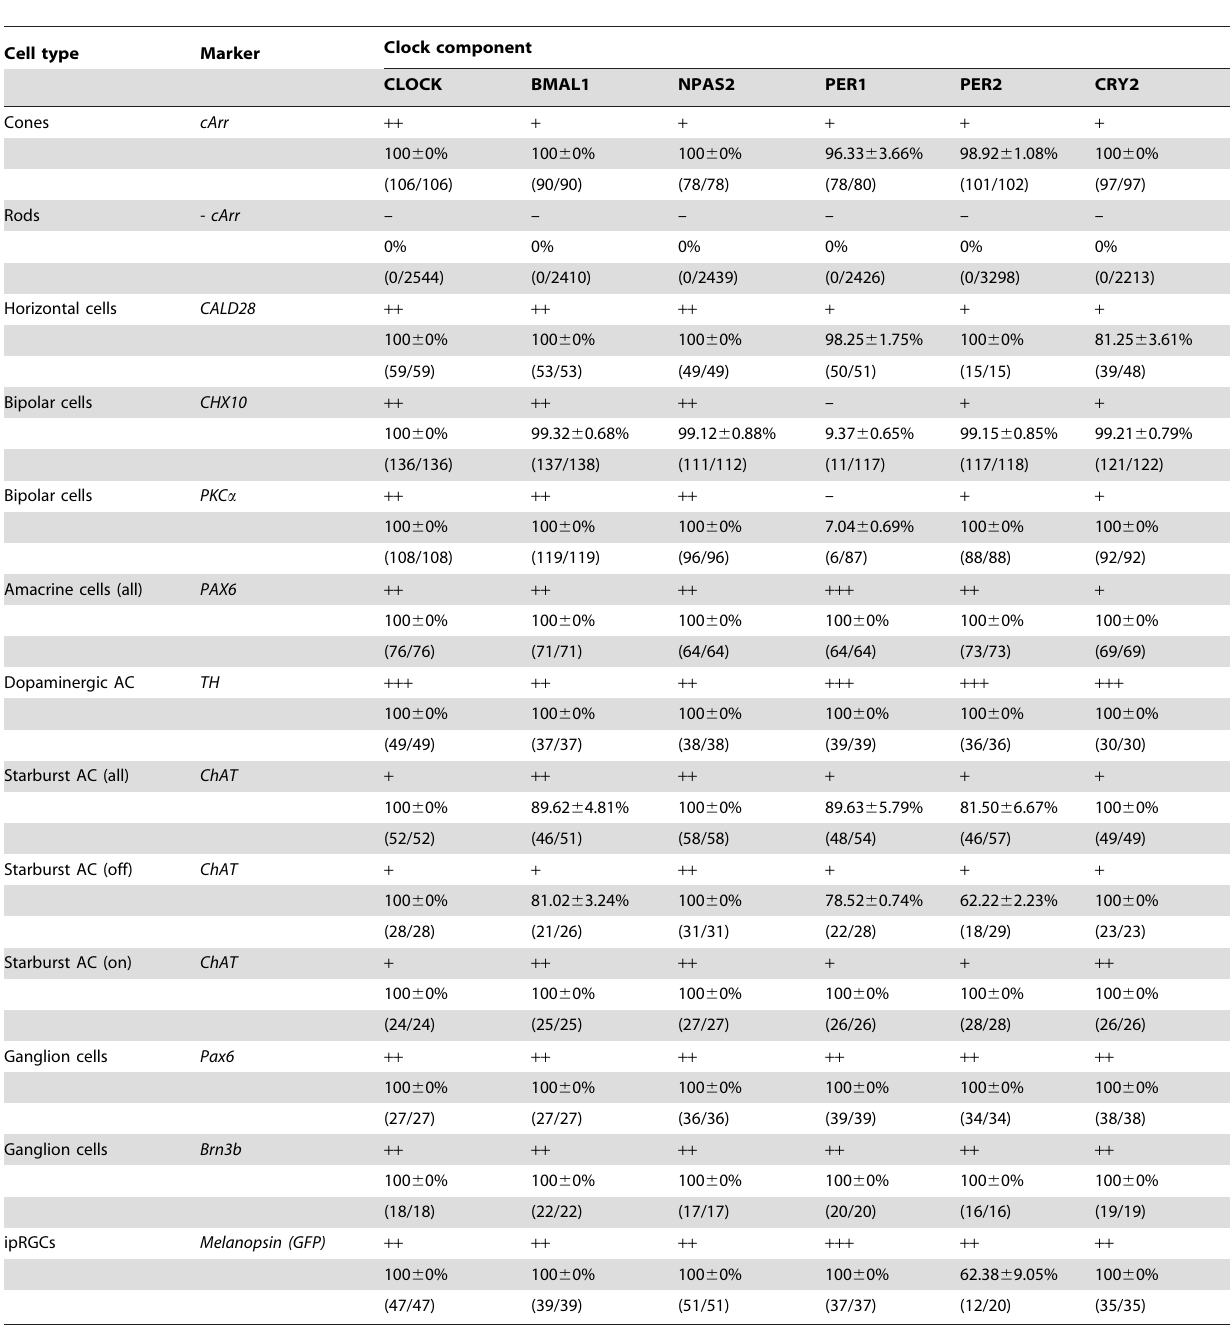
Table 3. Proportion of cells among identified retinal neurons that express the core circadian clock components at ZT02/06.